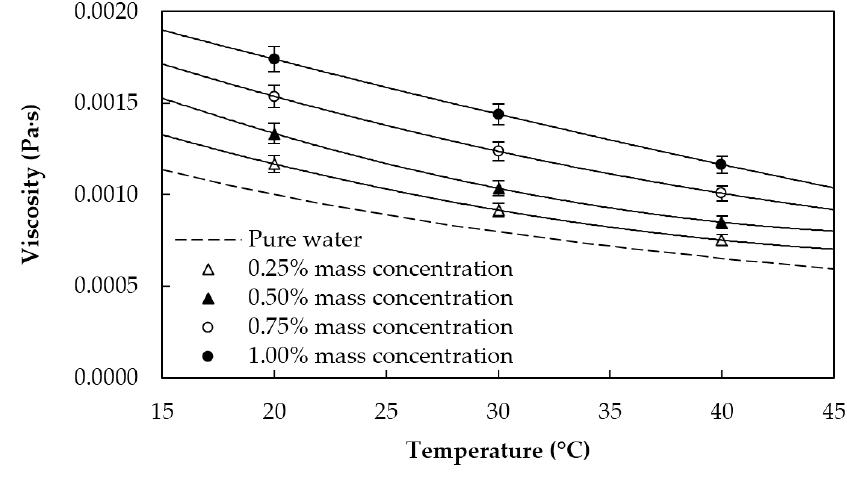
Figure 6. Viscosity of the sulfonic acid-functionalized graphene nanoplatelet water-based nanofluids and water [37].